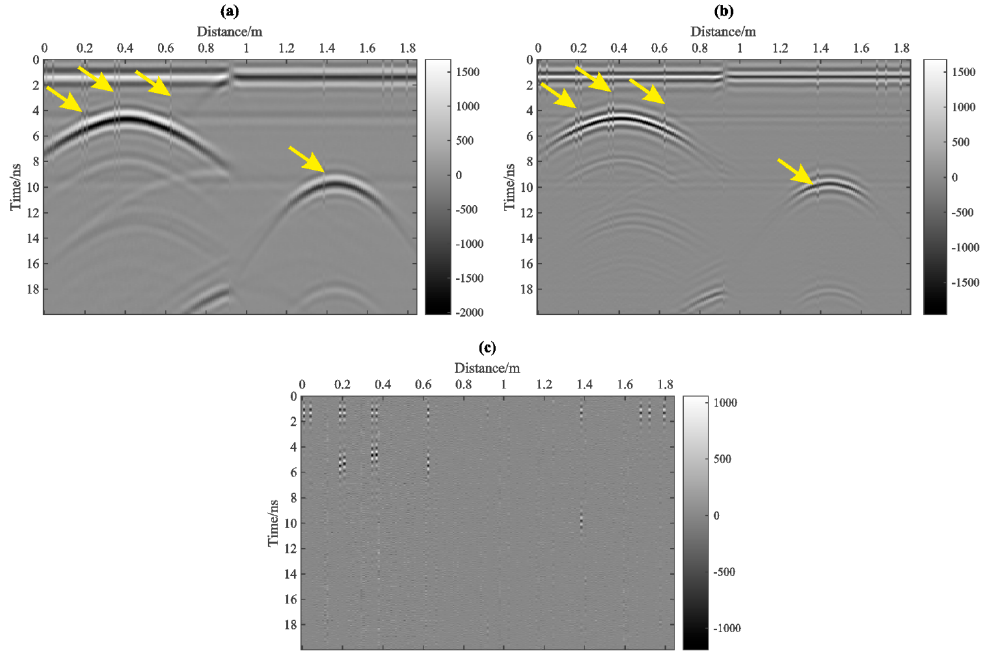
Figure 11. IMF-slices of the model data using VMD. ( a − c ) show the IMF-slices 1 − 3, respectively.